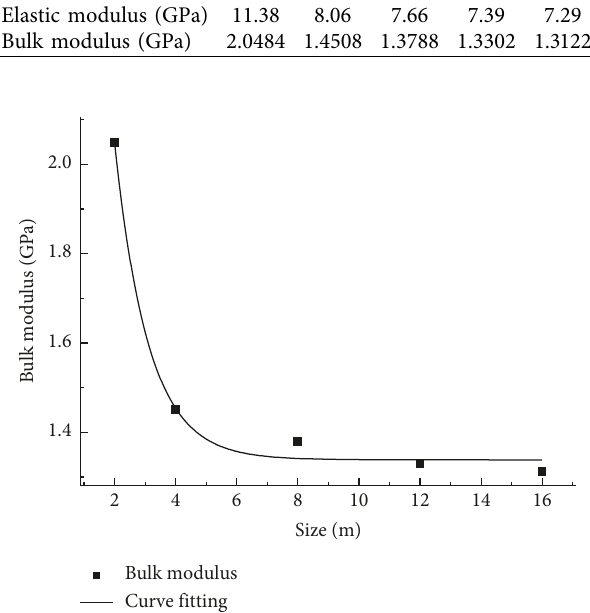
Figure 9: Fitting curves of bulk modulus with different